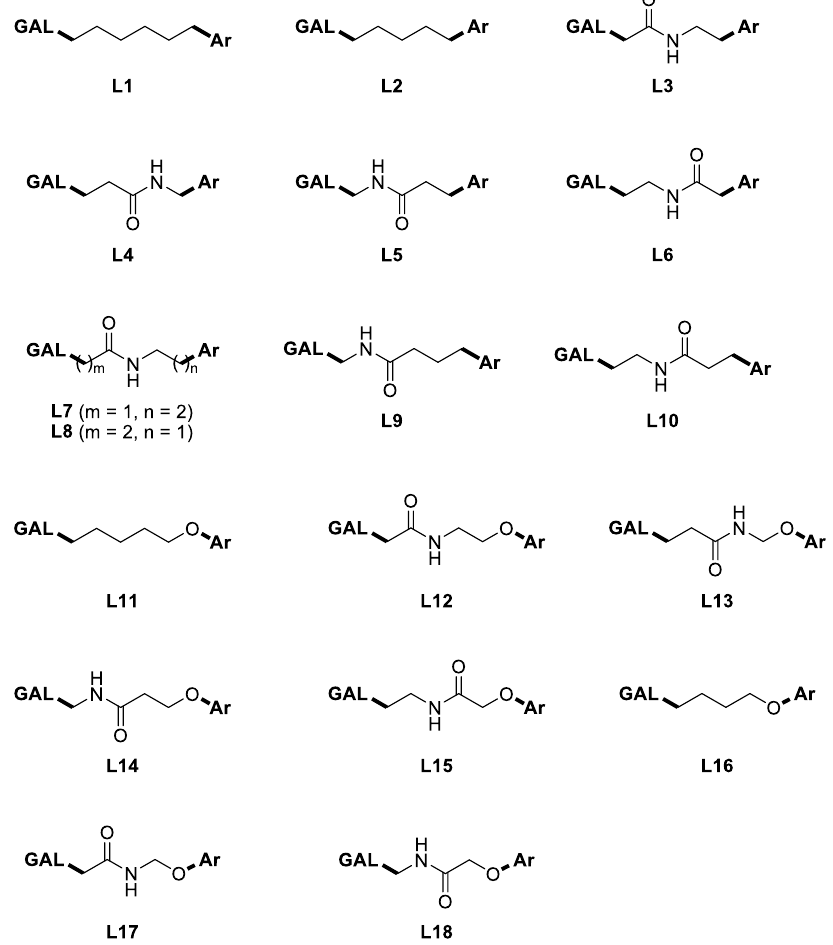
Figure 3. Linkers used in the design of ed galantamine hybrids.